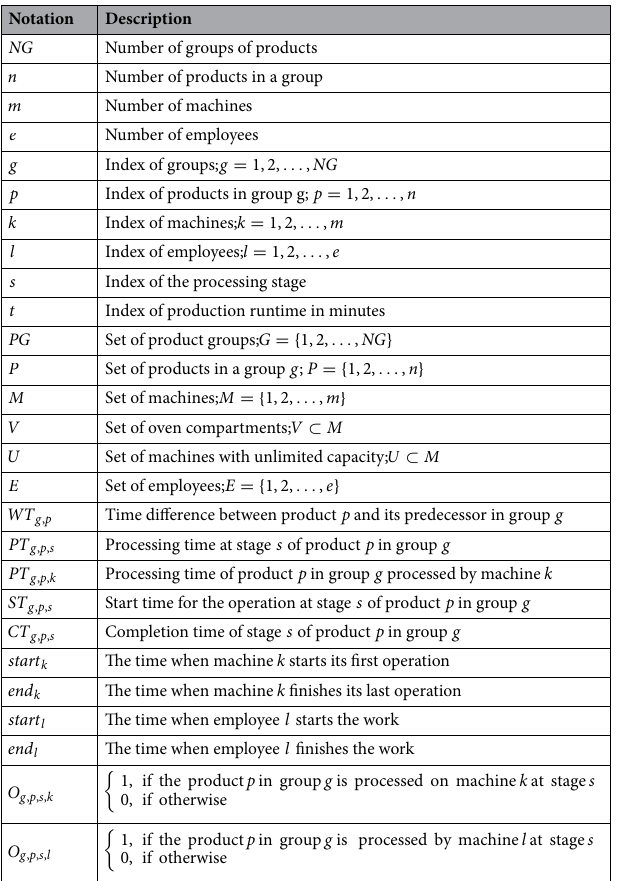
Table 2. Notations used in hybrid no-wait flow shop scheduling model